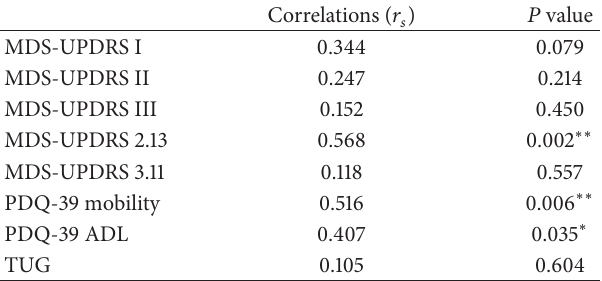
Table 2: FOG-Q correlations ( 𝑛 =